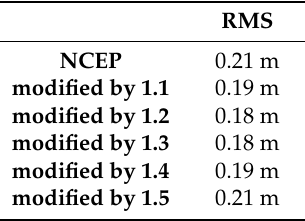
Table 6. RMS difference of non-tidal sea level anomalies between the model and tide-gauge observations at